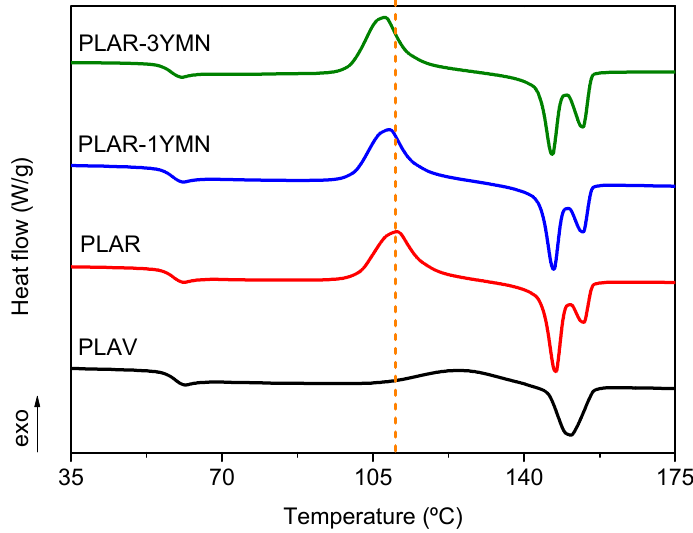
Figure 7. DSC scans corresponding to the second heating of the materials.